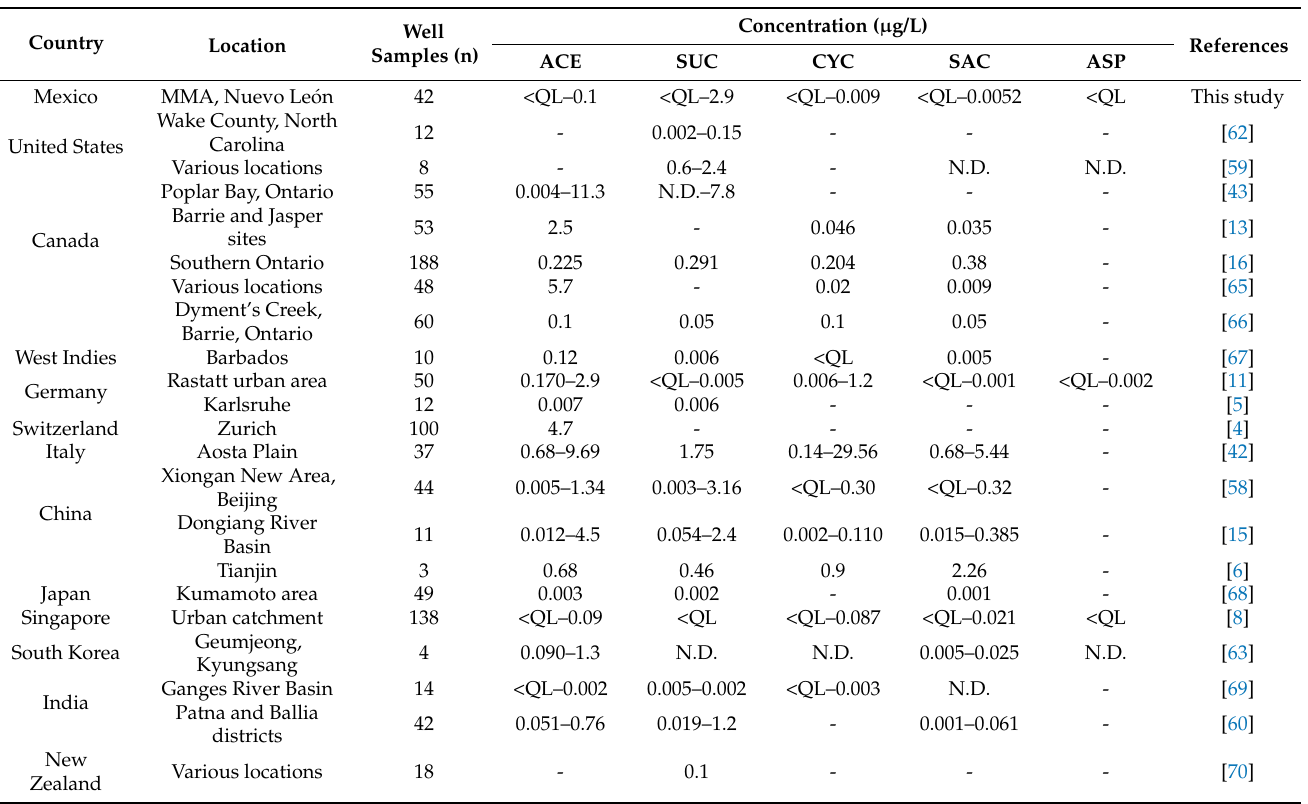
Table 3. Concentrations of Asws detected in urban groundwater systems from different worldwide